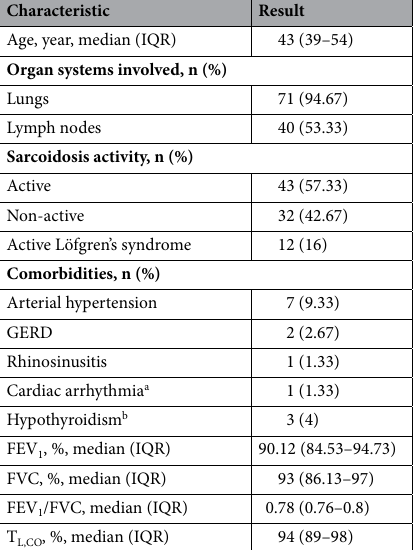
Table 1. Characteristics of study participants. a Other than atrial fibrillation, not related to sarcoidosis heart involvement; b currently in